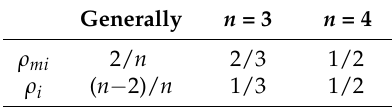
Table 1. Equilibrium values of ρ i and ρ mi